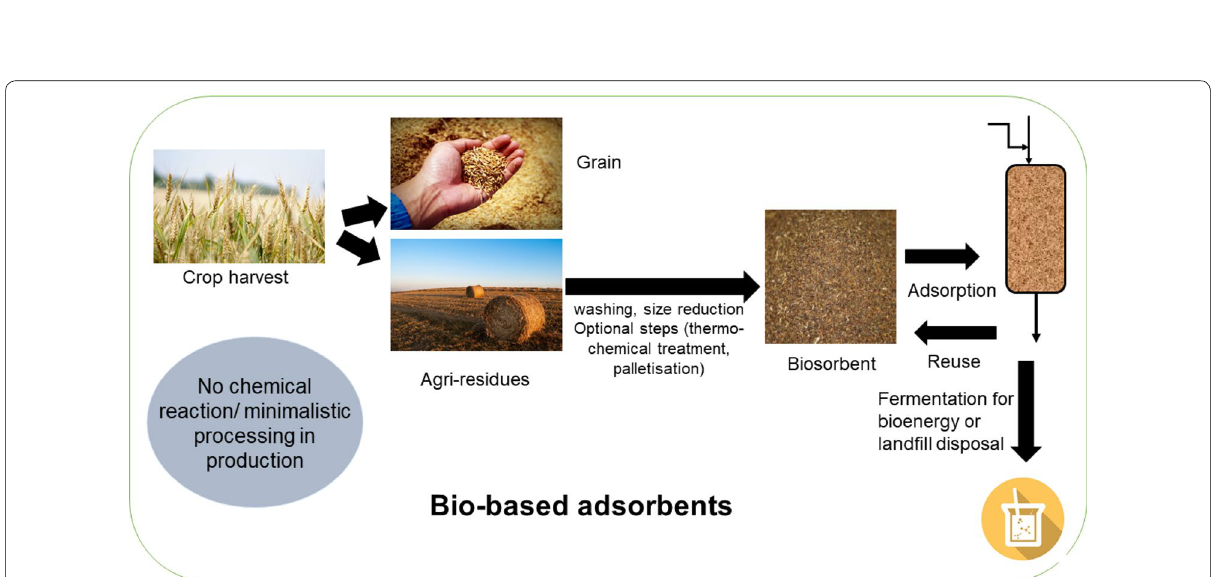
Fig. 2 Structure of lignocellulosic biosorbent depicting three major components of biomass —cellulose, hemicellulose, and lignin [Ref. (Rubin 2008)] (Copyrights Nature Publishing Group, 2008. Reprinted with permission from the publisher)